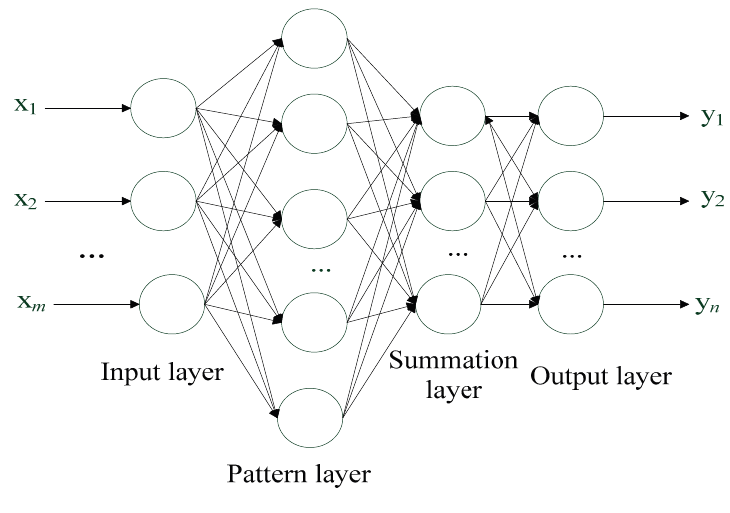
Figure 4. Structure of probabilistic neural